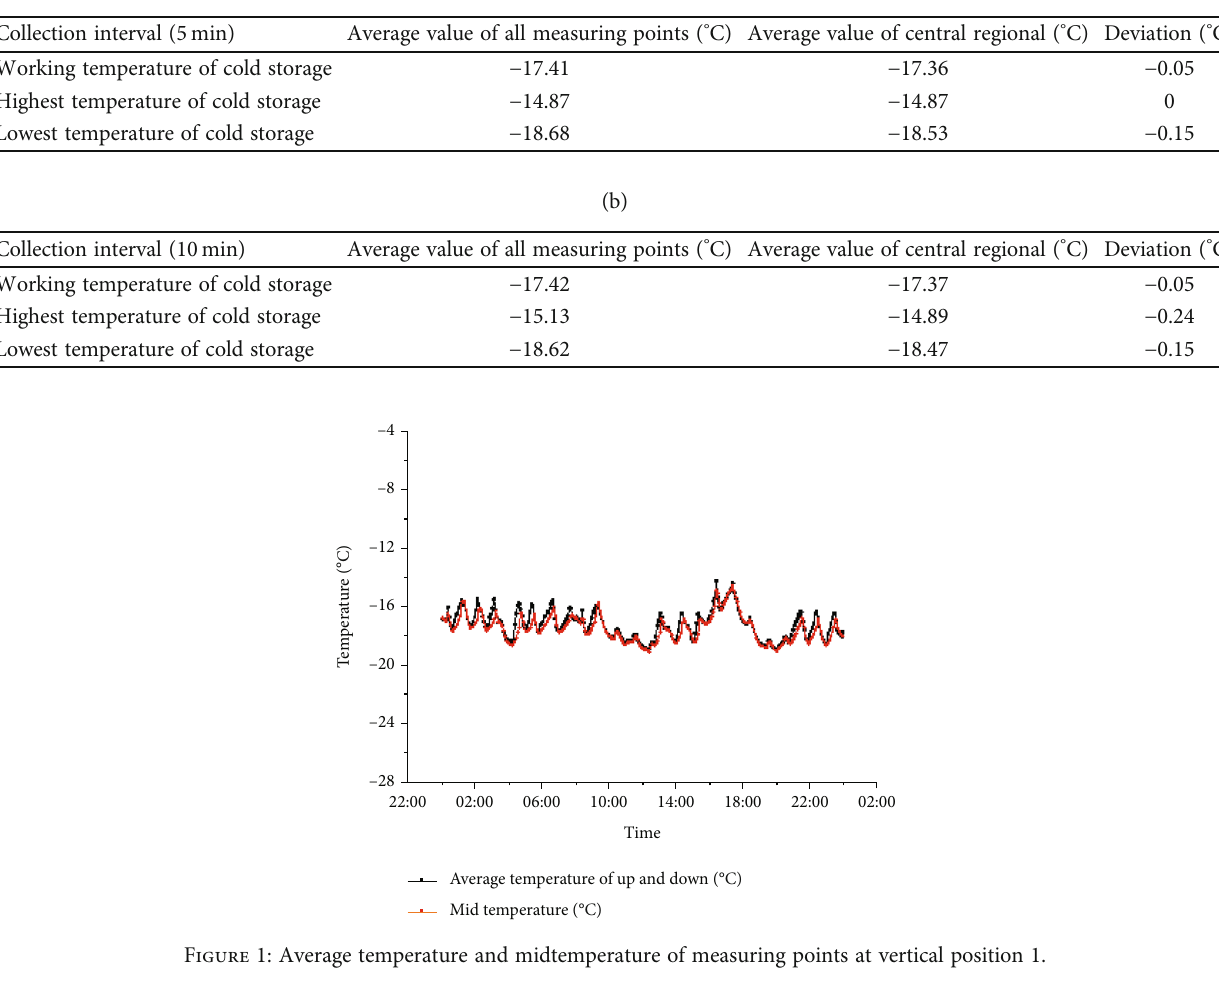
Table 1: Comparison of the temperature measurement position in storage.